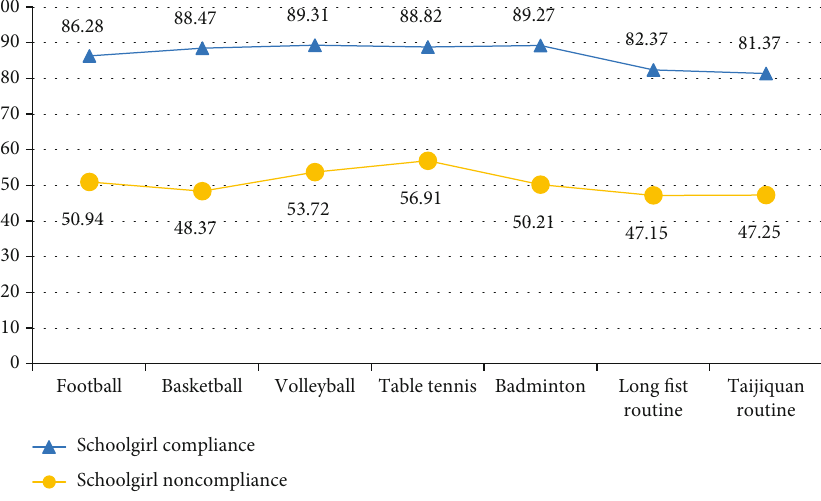
Figure 2: Comparison of PE examination standard rate of girls in di ff erent